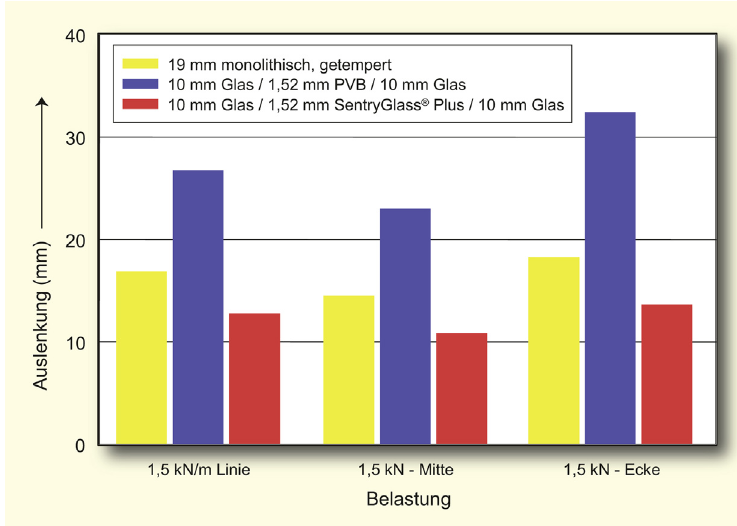
Figure 4: Comparison of deflection rates among sample panels made of SPSG and laminates with PVB or SentryGlas®, each exposed to linear and point